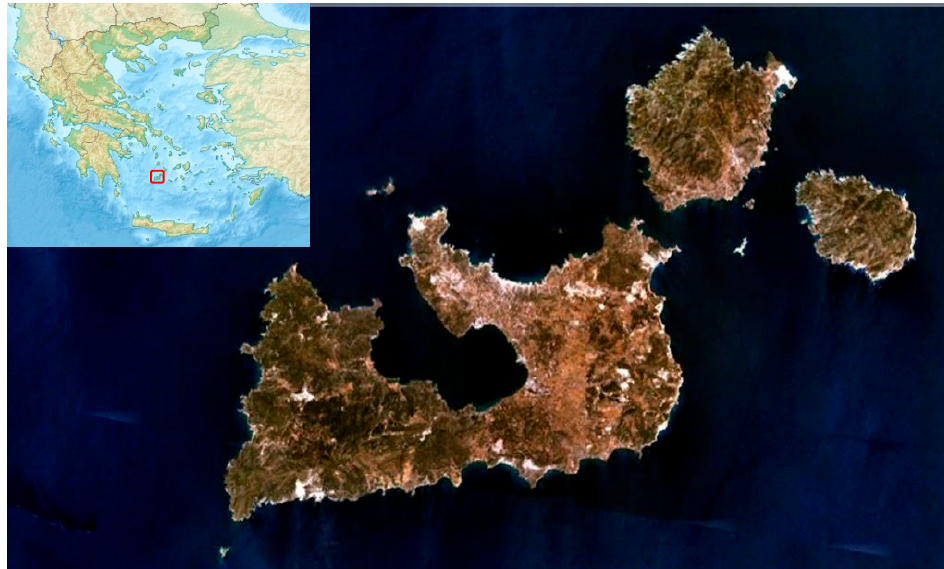
Figure 1. Milos Island, Cyclades, Greece. The red frame indicates the location of Milos in the Cyclades complex in the Aegean Sea. Milos is the main island in the image, obtained from World Wind, NASA.